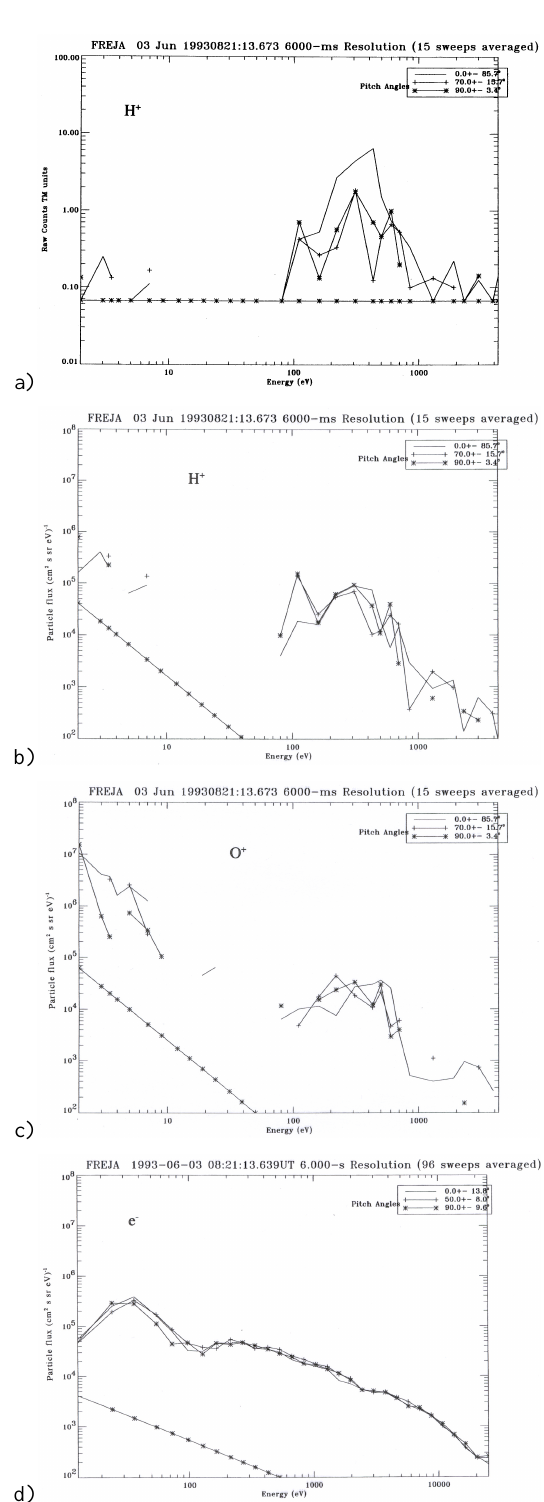
Fig. 3. Energy spectra of H + (a) and (b) and O + (c) ions and of the precipitating energetic electrons occurring simultaneously (d) in orbit 3172. For H + ions both the count rate and particle flux are shown as a function of energy, as the count rate gives information about the statistical uncertainty of the data points. The straight line shows the 1-count-per-sample-period